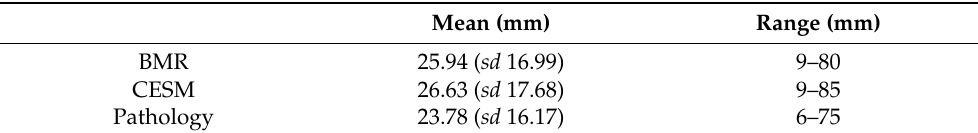
Table 3. Means of the maximum diameter of target lesions assessed by BMR and CESM compared to histopathology.